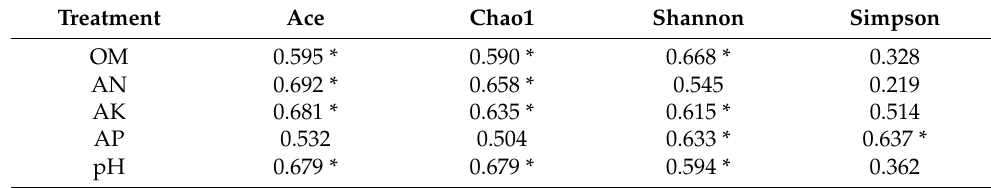
Table 3. Correlations between soil properties and microbial richness and diversity